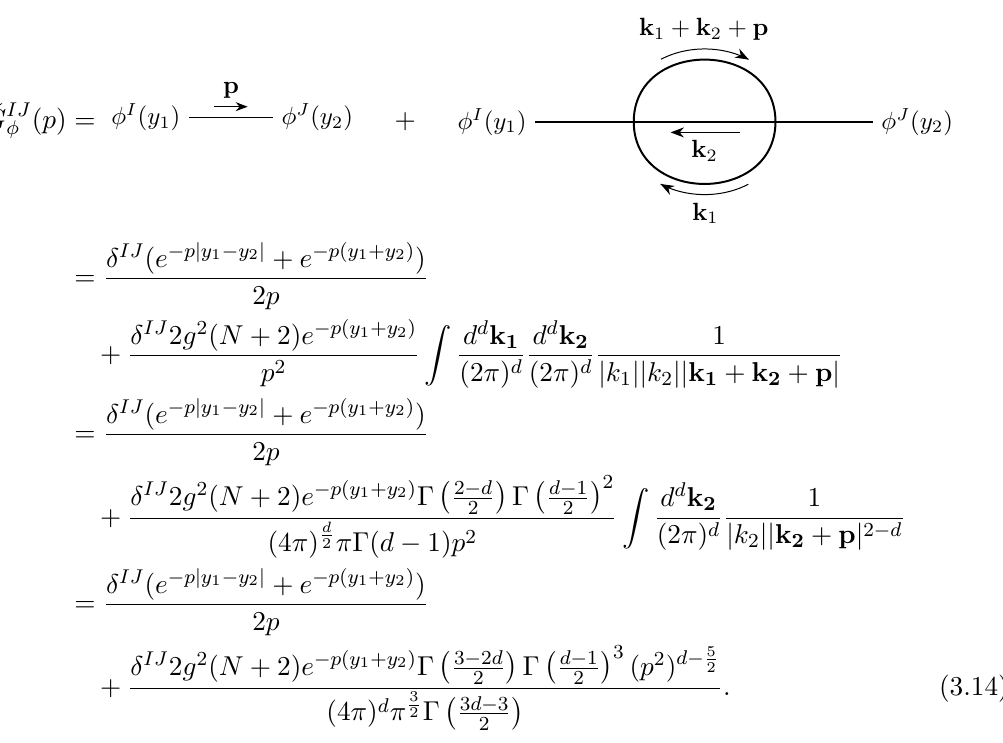
of the corresponding Feynman diagram